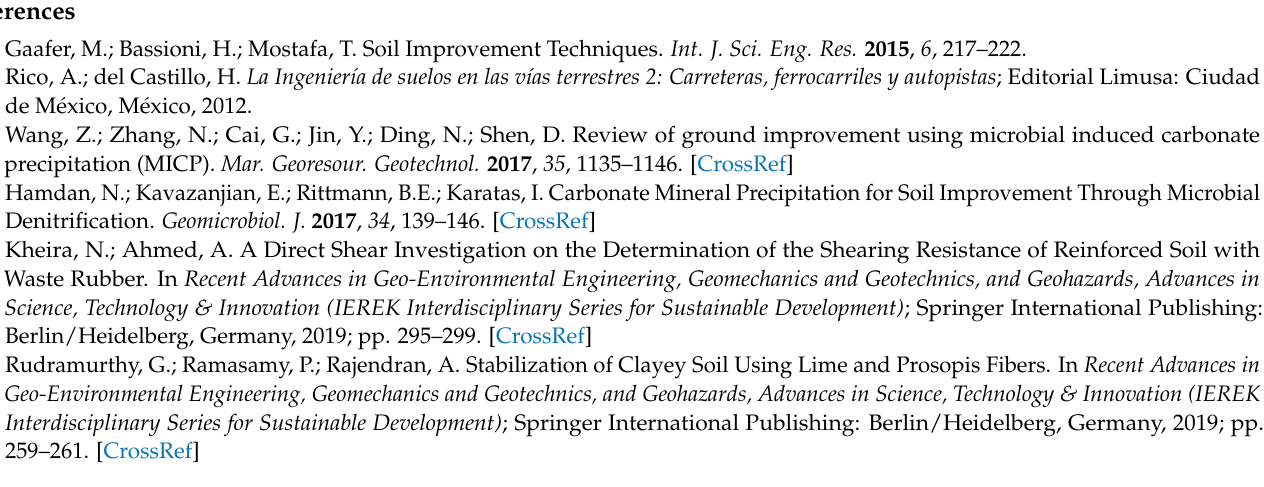
Figure 13. Boxplots evidencing the variation in log10 unitary deformation due to various experi- mental conditions. Note: *statistically significant difference between experimental and control con- ditions.